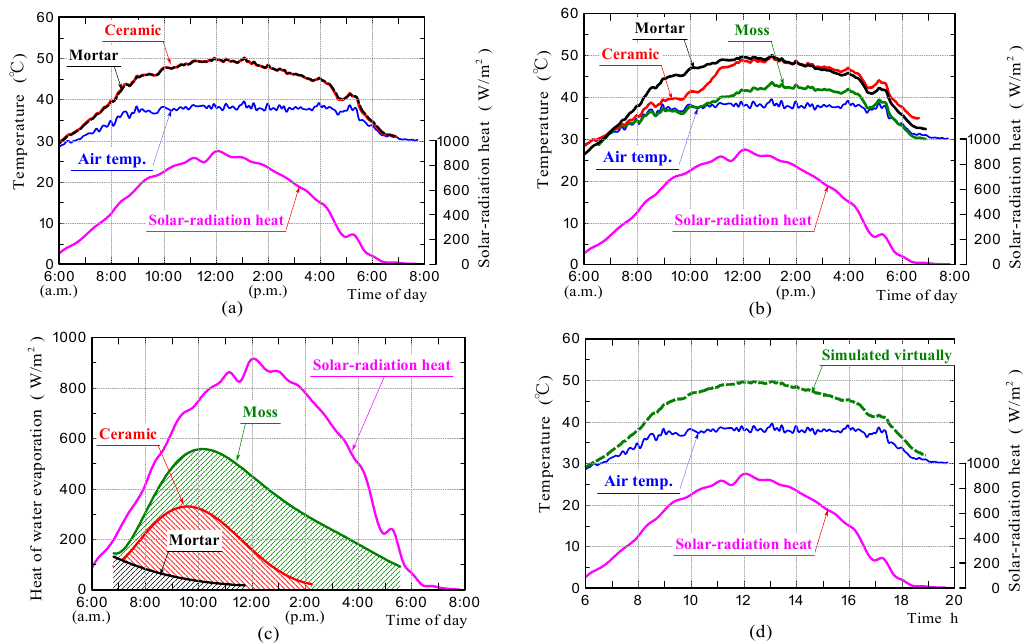
Figure 15. Surface-temperature changes of samples in the non-water absorbing and water absorbing states obtained by FEM analyses ( a , b ), heat of water evaporation ( c ), and surface-temperature changes of the moss-covered sample, which was simulated virtually using a different specific heat and thermal conductivity ( d ).